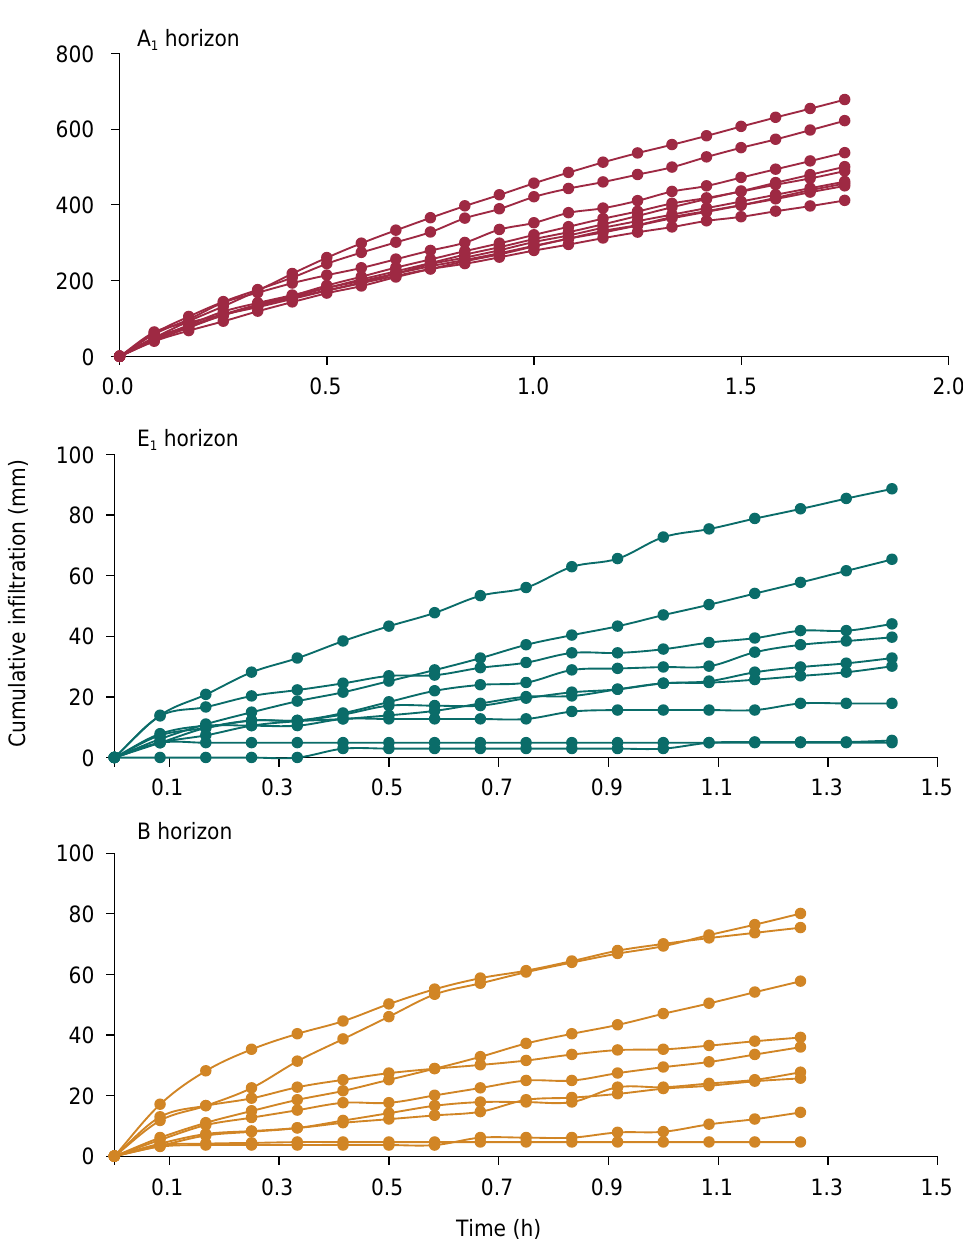
Figure 1. Cumulative infiltration rate versus time measured with a double ring infiltrometer at the top of A 1 , E 1 , and B horizons of nine plots of a Typic